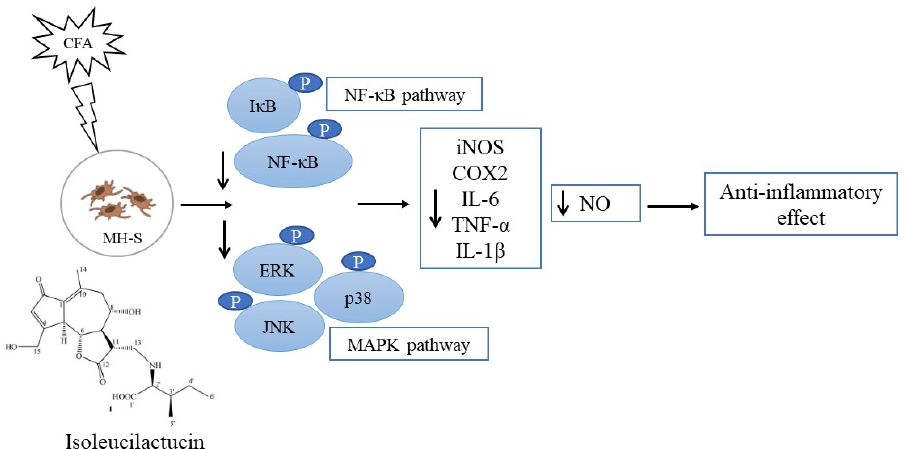
Figure 6. Proposed mechanistic model of the role of isoleucilactucin on CFA-induced inflammation in MH-S cells.